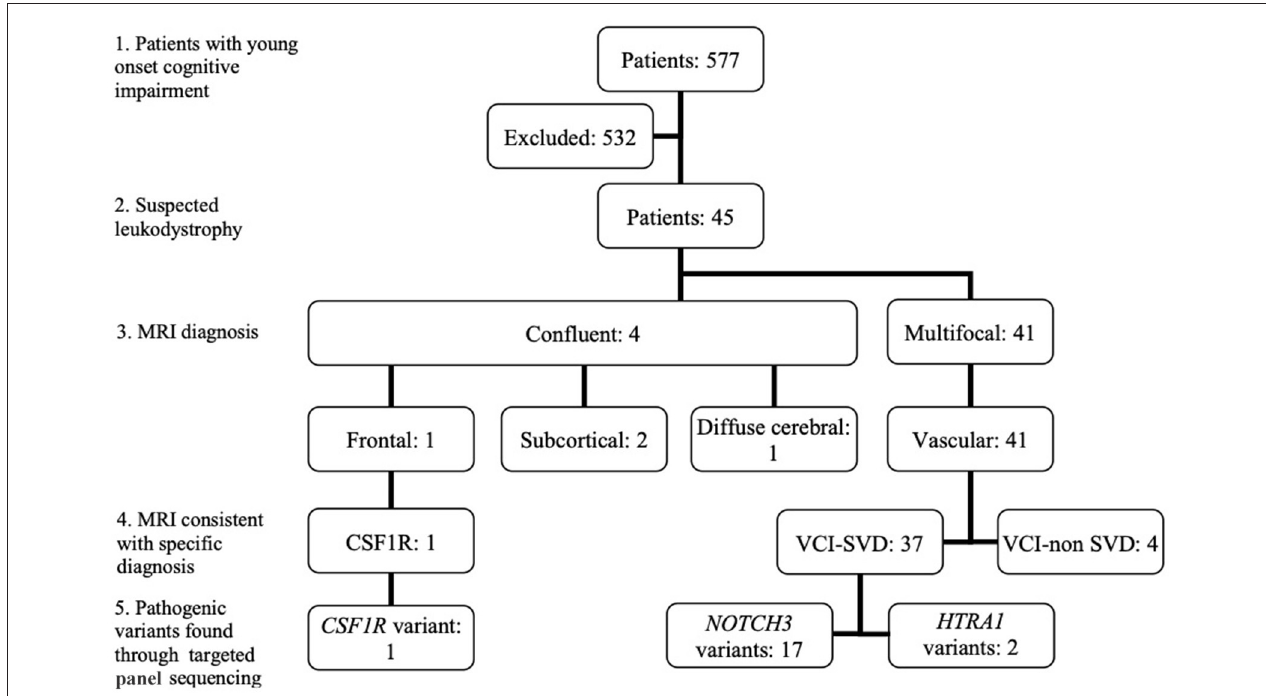
FIGURE 1 | Classification of patients based on MRI brain diagnostic algorithm and pathogenic variants found. (1): Patients with young onset cognitive impairment; (2): Patients with suspected leukodystrophy on MRI Brain; (3): Classification of MRI brain findings based on van der Knapp et al.’s criteria; (4): Whether MRI brain was consistent with the diagnosis of a specific leukodystrophy; (5). Pathogenic variants found through targeted panel sequencing. CSF1R, CSF1R related leukoencephalopathy; VCI-SVD, vascular cognitive impairment secondary to small vessel disease; VCI-non SVD, vascular cognitive impairment not caused by small vessel